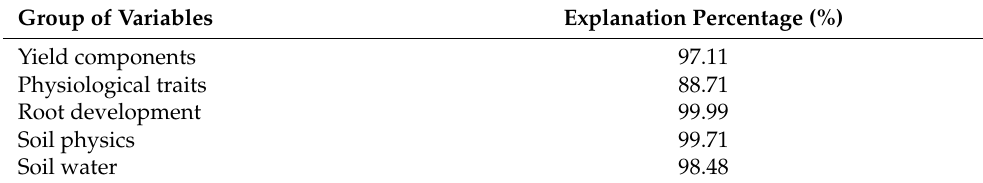
Table 3. Percentage explanation of the first major component of the variables Yield components, Physiological traits, Root development, Soil physics, and Soil water.